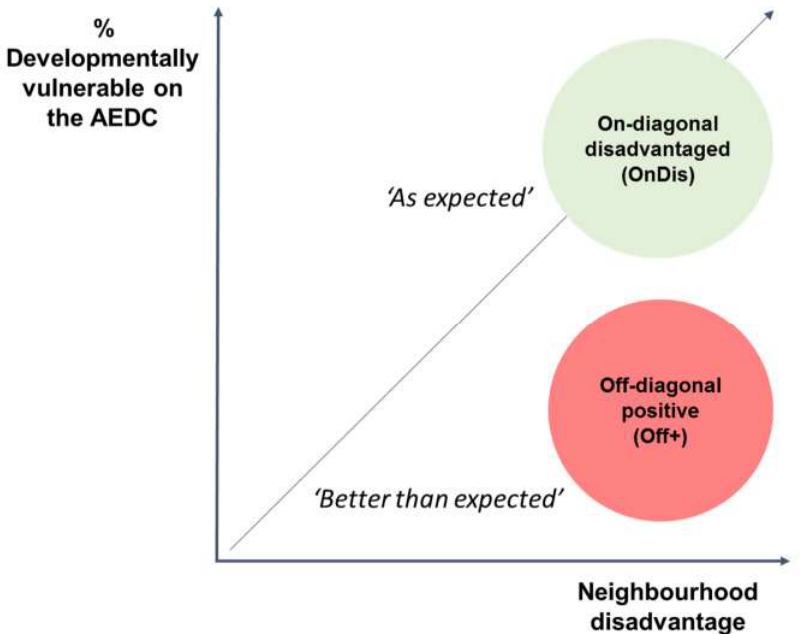
ff -diagonal local communities. Source: adapted from Goldfeld et al. 2018 Figure 1. On- and off-diagonal local communities. Figure 1. On- and o